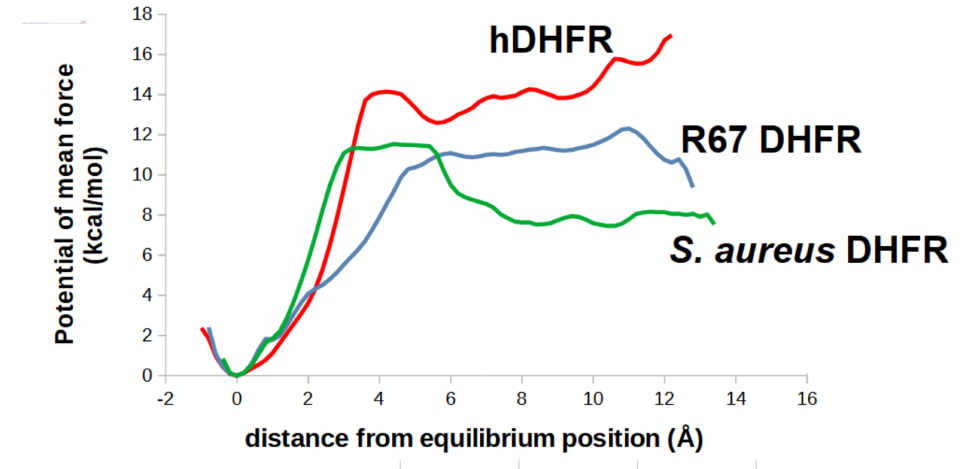
Figure 8. Potentials of mean force of the separation of ligand 32 from each of the three examined dihydrofolate